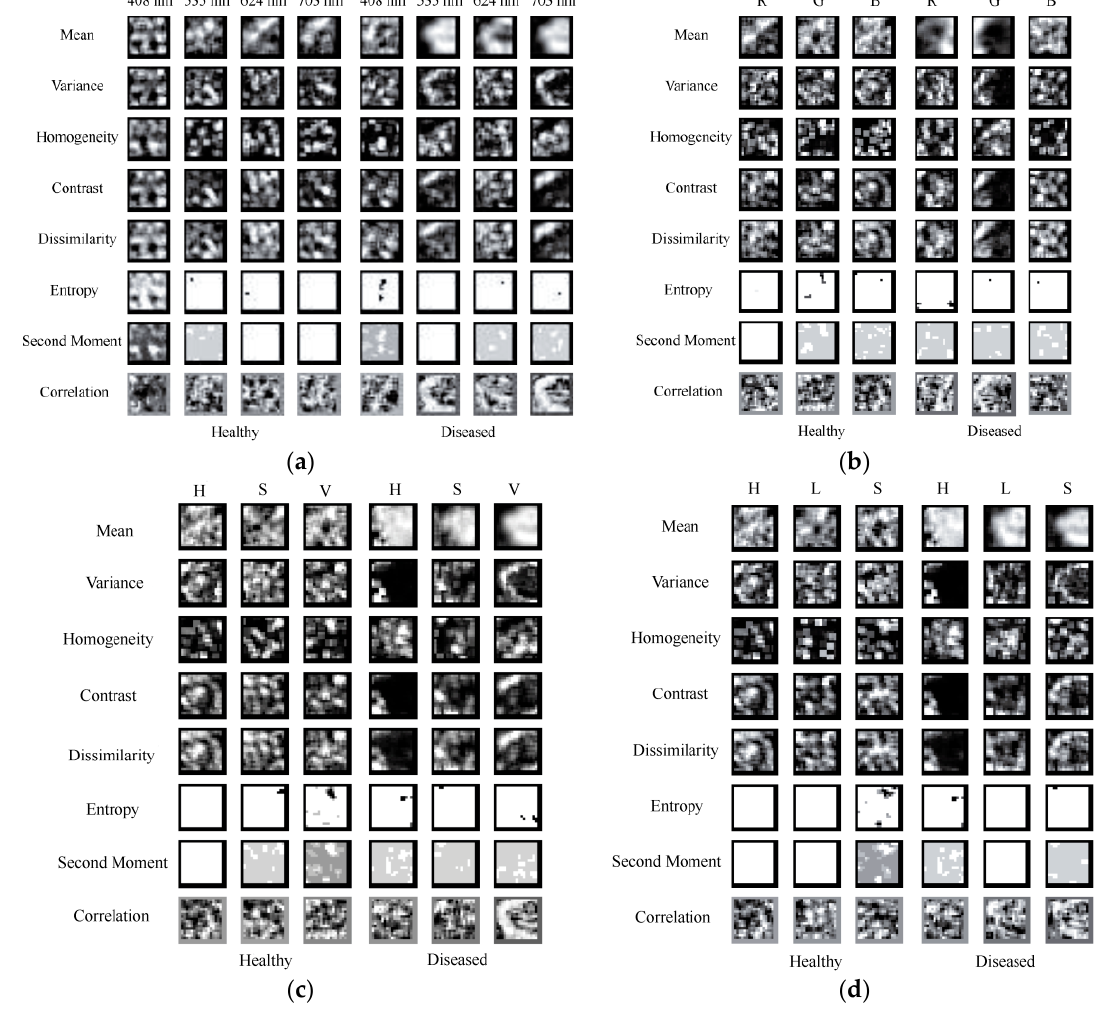
Figure 8. Texture images extracted from ( a ) gray images; ( b ) RGB images; ( c ) HSV images and ( d ) HLS images.